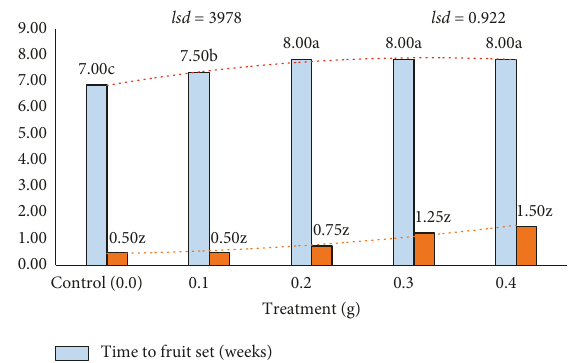
Figure 1: Influence of Trichoderma -based biofertilizer on days to first appearance. Figures not sharing a common letter in a column differ significantly at 0.05